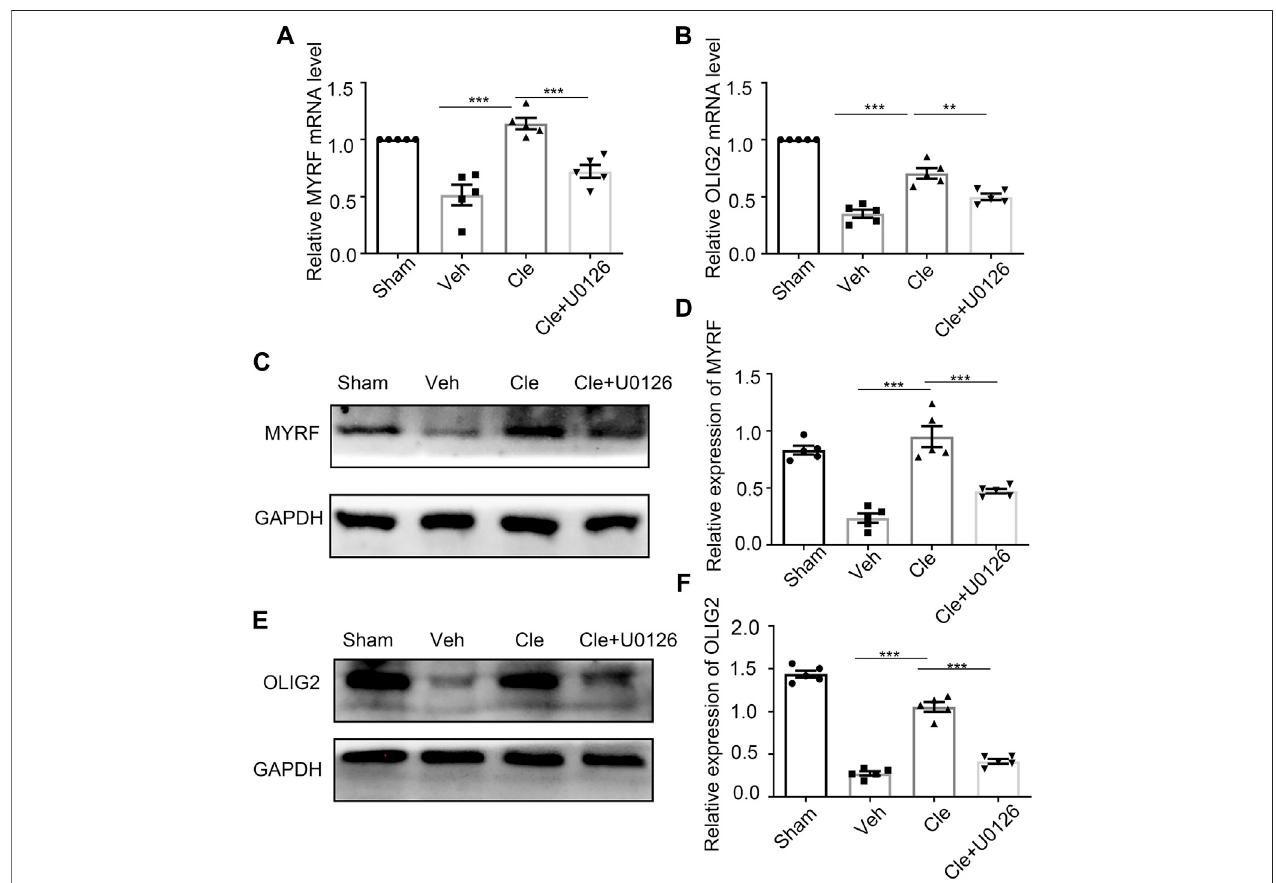
FIGURE 4 | In fl uences of ERK1/2 activity on Myrf and Olig2 expression (A,B) qRT-PCR analysis of Myrf (A) and Olig2 (B) expression in the spinal cords from the Sham, Veh,Cle, and Cle +U1026 group. (C,E) Western blot analysisofMyrf (C) and Olig2 (E) wasevaluated. The expression ofMyrfand Olig2is normalized toGAPDH expression. (D,F) Quantitative analysis of the protein levels of Myrf and Olig2. * p < 0.05, ** p < 0.01, and *** p < 0.001 ( n = 5 for each group).